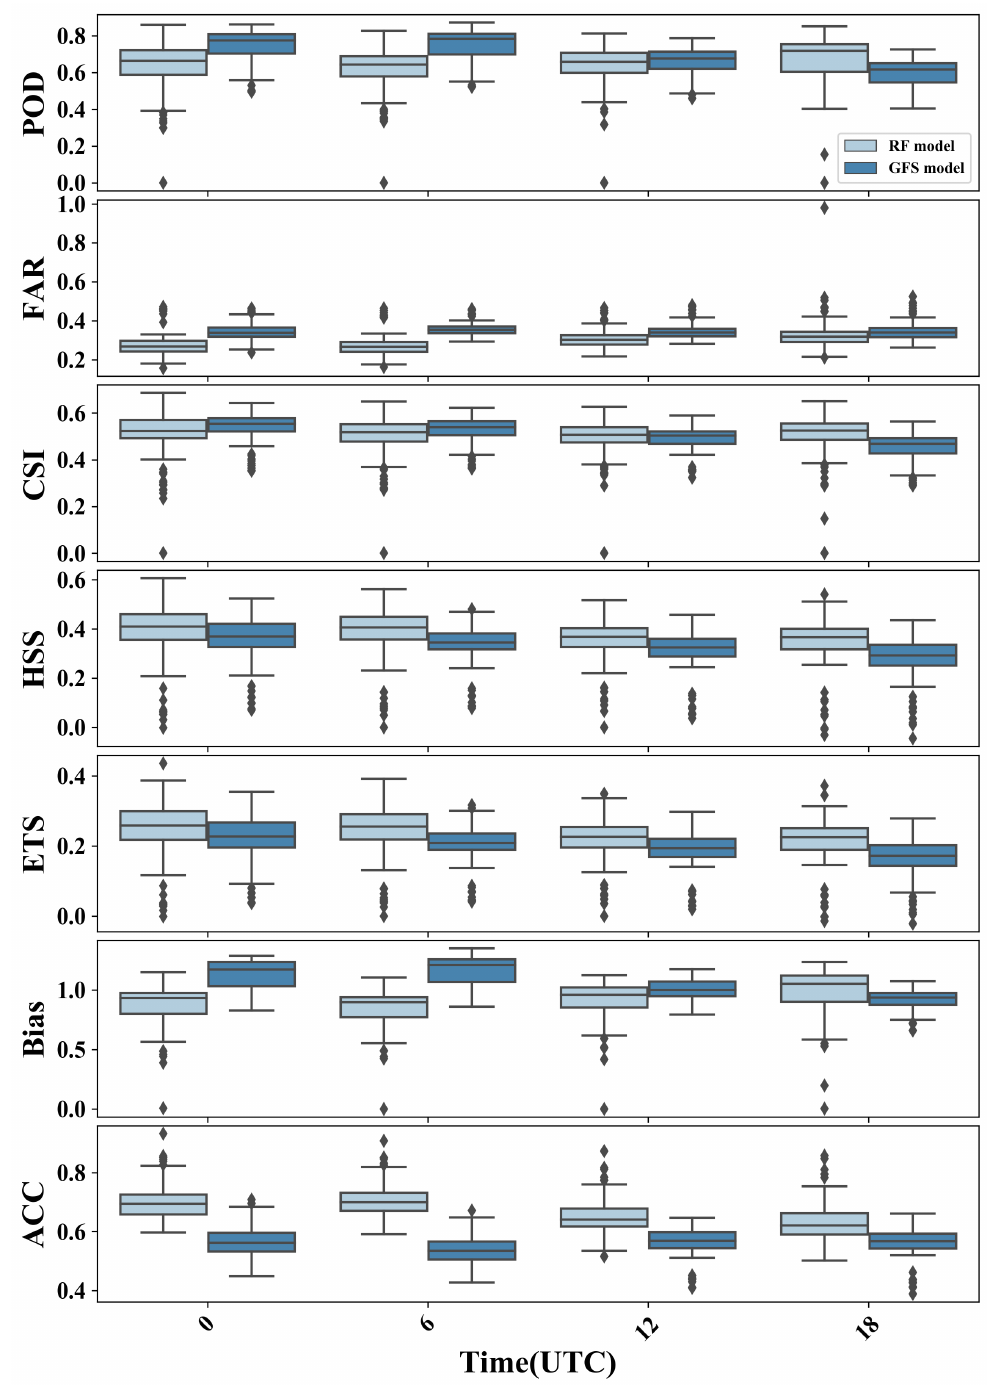
Figure 22. The diurnal variation of evaluation scores for rain area determination and precipitation grades estimation on RF model and GFS model against GPM data during summer 2019, distributions of statistical values at six hour intervals are interpreted in box plots. Box diagrams indicate the 25th, 50th, and 75th percentiles whereas the periphery of the box extends to 1.5 times of the quartile deviation (25th–75th percentile). Outliers are indicated by black